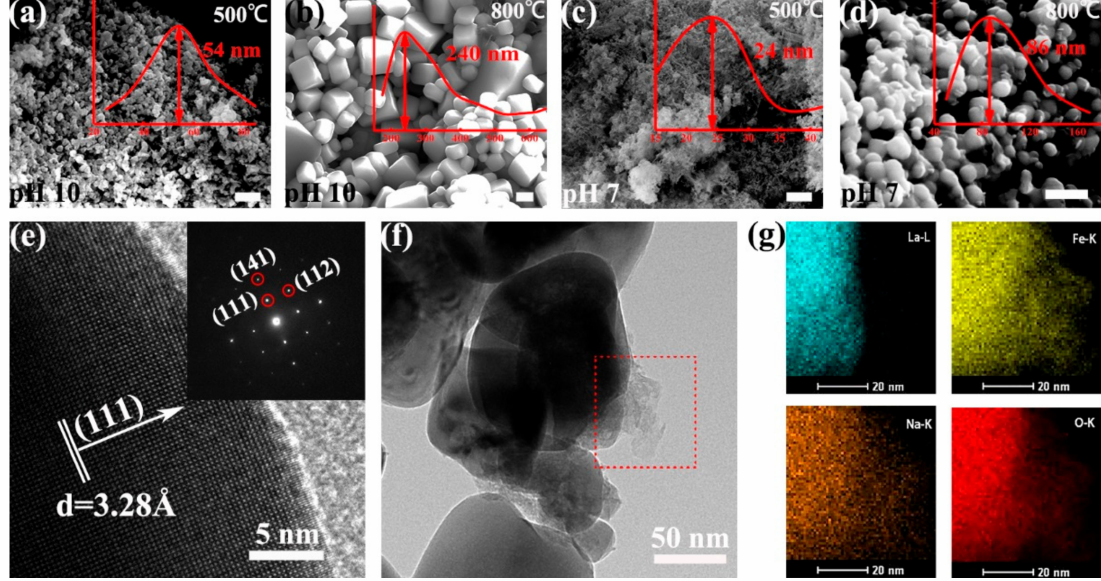
Figure 3. SEM images ( a – d ), HR-TEM and SAED images ( e , f ) of the LFO (La/Fe 3:7) calcined at 500 ◦ C and 800 ◦ C, respectively, and element mapping ( g ) of Fe, La, Na, and O on the surface of crystalline LFO nanoparticles after calcination at 800 ◦ C. The inset red curves are the size distribution of the LFO nanoparticles. The scale bar is 300 nm in both SEM images.